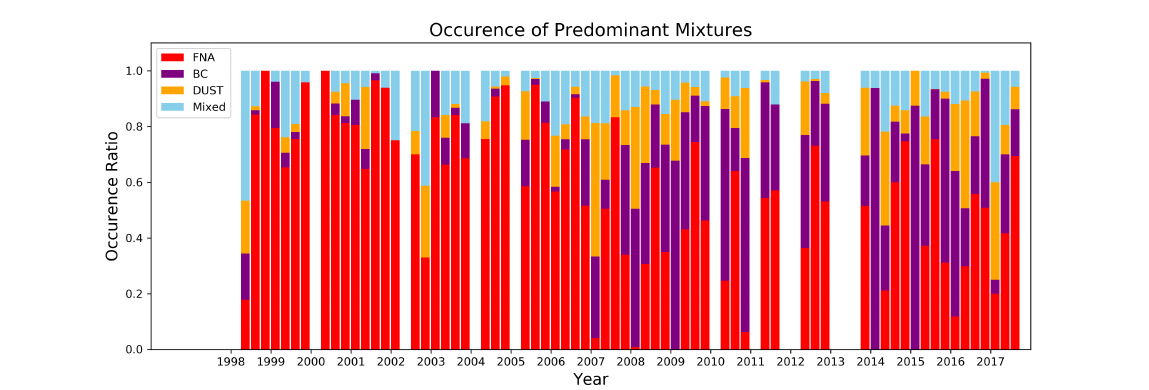
Figure 8. Seasonal timeseries of the occurrence ratio of each aerosol type in the period 1998–2017 with classification flags obtained from the Mahalanobis